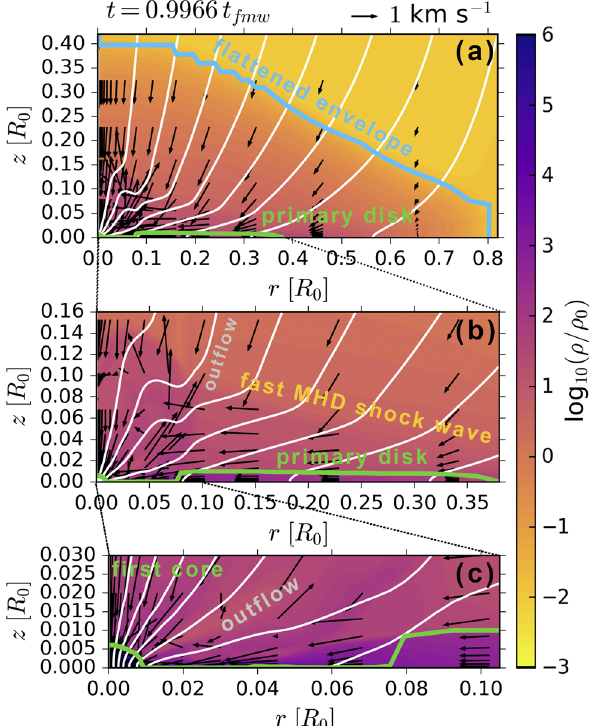
Figure 1: Distributionofdensity ( color fi lling ) ,velocity fi eld ( arrows ) ,and poloidal magnetic fi eld ( white lines ) in the simulation of the collapse of the magnetic rotating PSC of mass M 10 ⊙ with initial radius R 0.1 0 = pc, and nondimensional parameters ε 0.3 t = . Panel ( a ) : Region with r and z R 0.4 0 ≤ containing the entire cloud. Blue line corresponds to the border of the cloud. Panel ( b ) : Region near the primary disk. Panel ( c ) : Central part of the cloud. Green line shows the boundary of the quasi - magnetostatic primary disk and the boundary of the fi rst hydrostatic